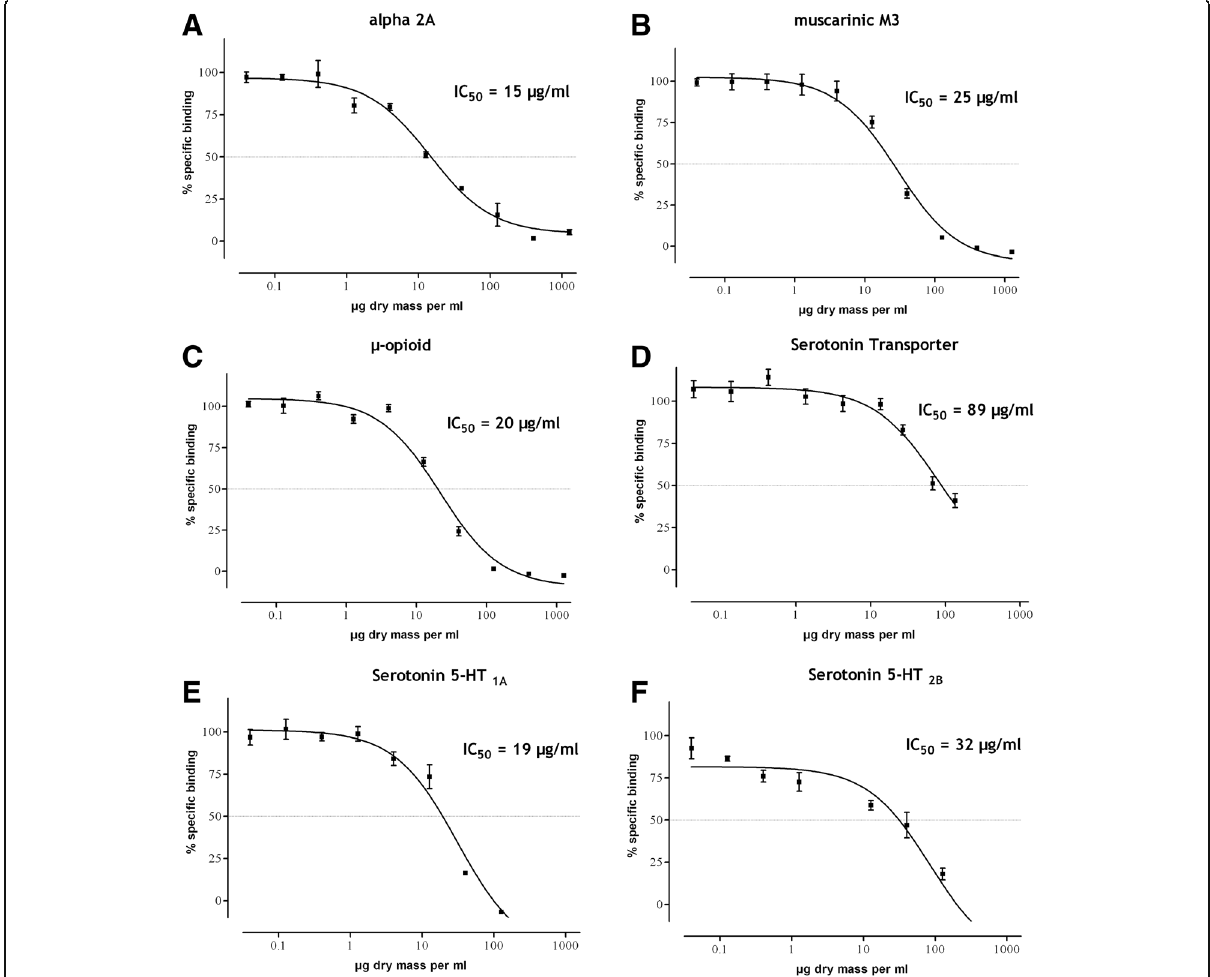
Fig. 1 Competition binding at several receptors . Competition binding of Salvia officinalis extract at the human adrenergic alpha 2A receptor expressed in Chem-1 cells ( a ), the muscarinic M3 receptor expressed in CHO cells ( b ), the human μ -opioid receptor expressed in CHO-K1 cells ( c ), the human serotonin transporter expressed in HEK293 cells ( d , Salvia off. tincture), the human serotonin 5-HT 1A receptor expressed in HEK293- EBNA cells ( e ), and the human serotonin 5-HT 2B receptor expressed in CHO-K1 cells ( f ). Summary curves over 2 – 3 independent experiments performed in duplicate (mean specific binding ± S.E.M.). The calculated IC 50 values are indicated above the figure. The horizontal dashed line marks 50% specific